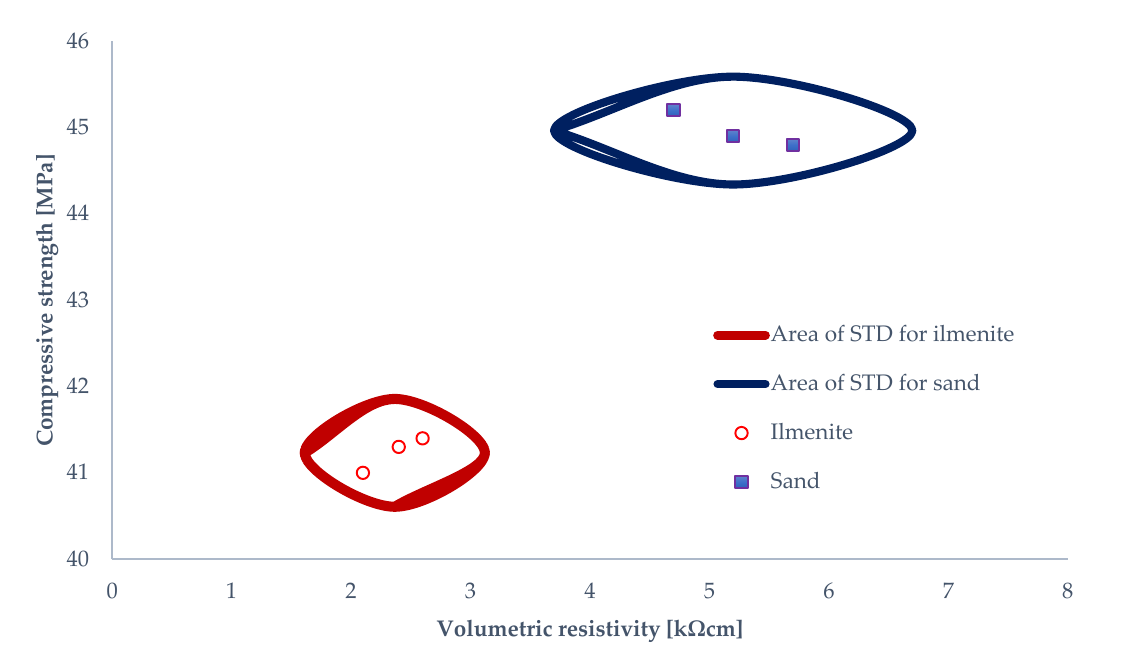
Figure 7. Correlation between the values of volumetric resistivity and compressive strength. As a final result, Figure 8 shows the correlation and standard deviation region for bulk resistivity and density. Ilmenite has a lower resistivity despite the higher density. All the graphs show that the mortar made of sand and ilmenite behaves differently.